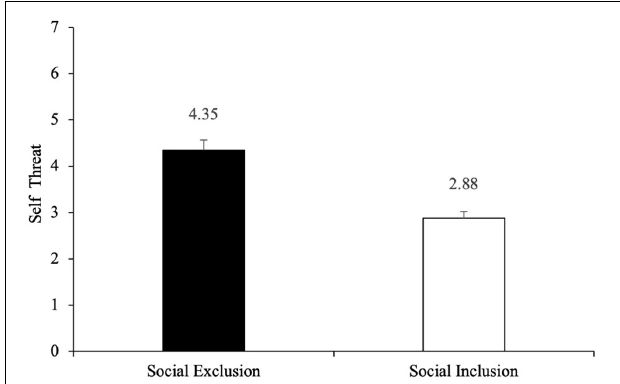
FIGURE 2 | Effects of social exclusion vs. social inclusion on self-threat. Error bars represent standard errors.